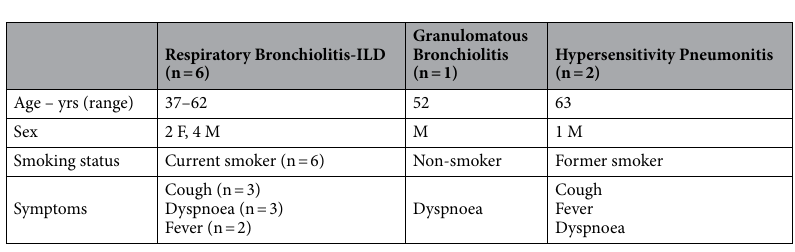
Table 2. Demographic and clinical features of patients with ILD with a prominent bronchiolar component.